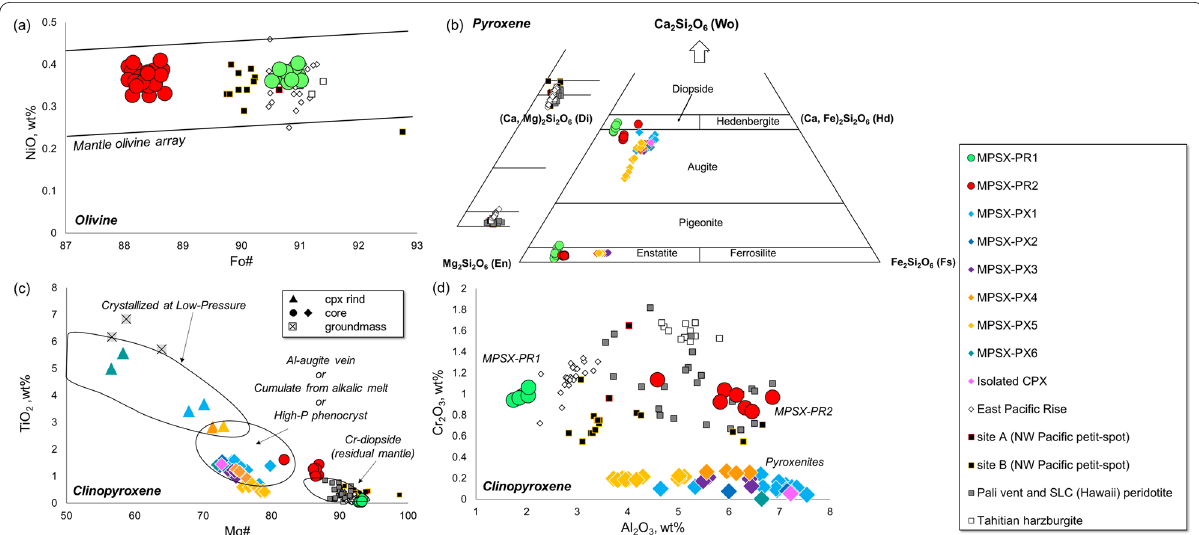
Fig. 5 Major-element compositions of minerals in ultramafic xenoliths. The circles describe the core parts of peridotite xenoliths, and the rhombuses describe pyroxenite xenoliths. Fo# and Mg# equal 100 Mg 2 + /[Mg 2 + Fe 2 + ] for olivine and clinopyroxene. Mantle olivine arrays are × + quoted from Takahashi et al. (1987). a Major-element compositions of olivine. b Ca–Mg–Fe pyroxene classification diagram, from Morimoto (1988). Symbols are the same as in ( a ). c TiO 2 versus Mg# clinopyroxene classification from Wass (1979). Cpx rind (triangles) is microcrystals surrounding each xenolith, and groundmass Ti-augite (box with x) is in 6K#1466R6-001 basalt. d Clinopyroxene major-element composition, of Cr 2 O 3 versus Al 2 O 3 . The detailed values are shown in Additional file 4: Table S2. The mineral compositions of abyssal peridotite (East Pacific Rise; Dick and Natland 1996; Regelous et al. 2016), peridotite xenoliths from NW Pacific petit-spots (site A, B; Yamamoto et al. 2014; Pilet et al. 2016), peridotite xenoliths from the Pali vent and Salt Lake Crater, Hawaii (Bizimis et al. 2007), and Tahitian harzburgite (Akizawa et al. 2017) are shown